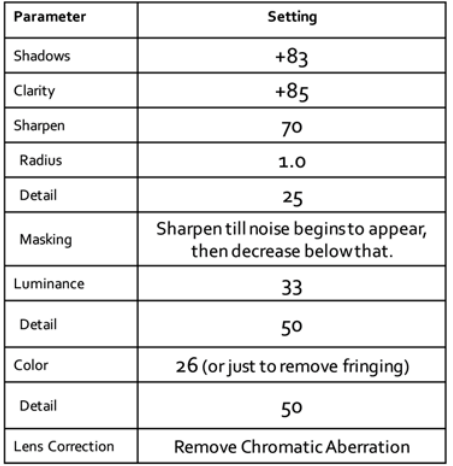
Table 4. Adobe Camera Raw